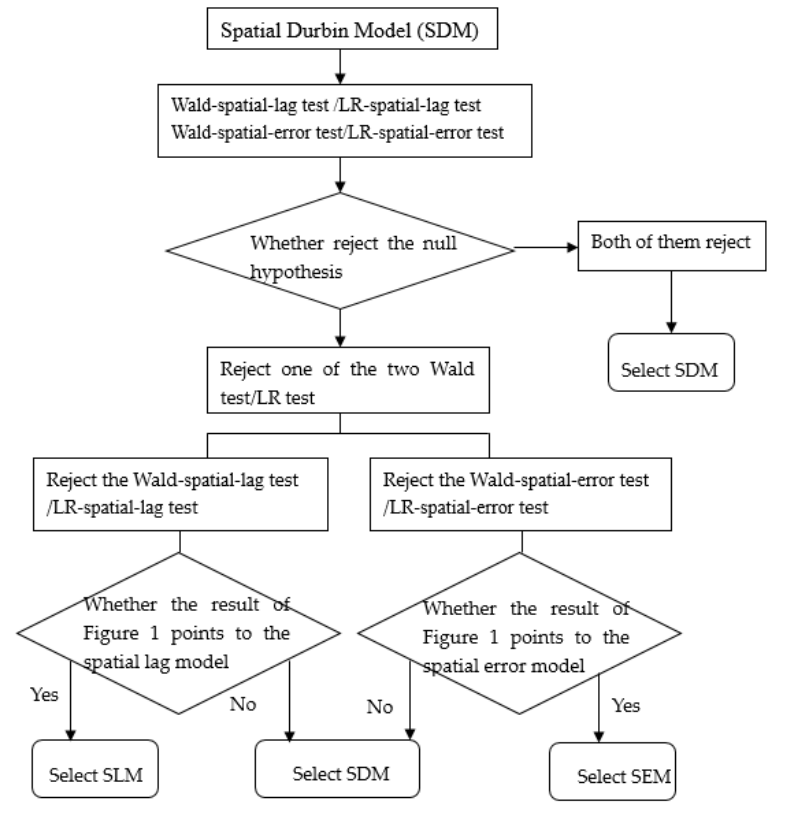
Figure 2. The selection of the SLM, SEM, and SDM.